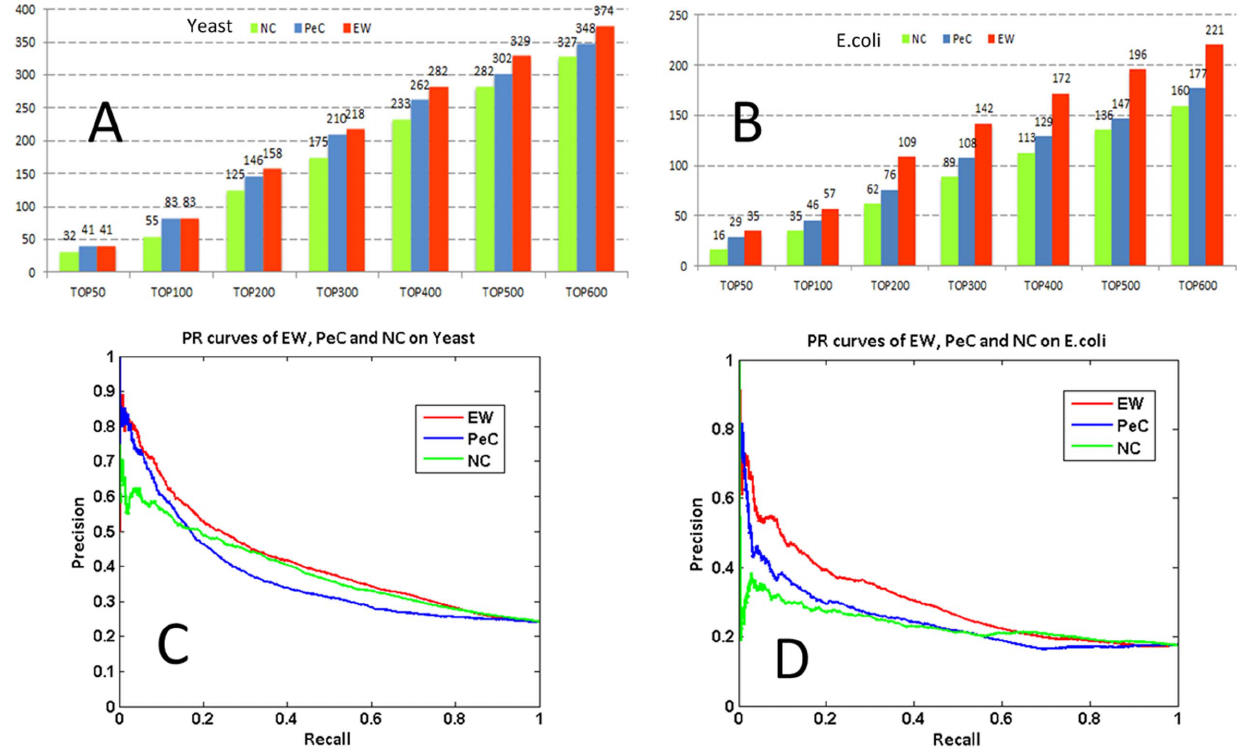
Figure 2. EW performance compare with NC and PeC methods. ( A )( B ): Comparison among the numbers of essential proteins identified by EW, NC and PeC on Yeast and E.coli , respectively, when selecting 50, 100, 200, 300, 400, 500 and 600 top ranked proteins; ( C )( D ): PR curves of EW, NC and PeC on Yeast and E.coli .